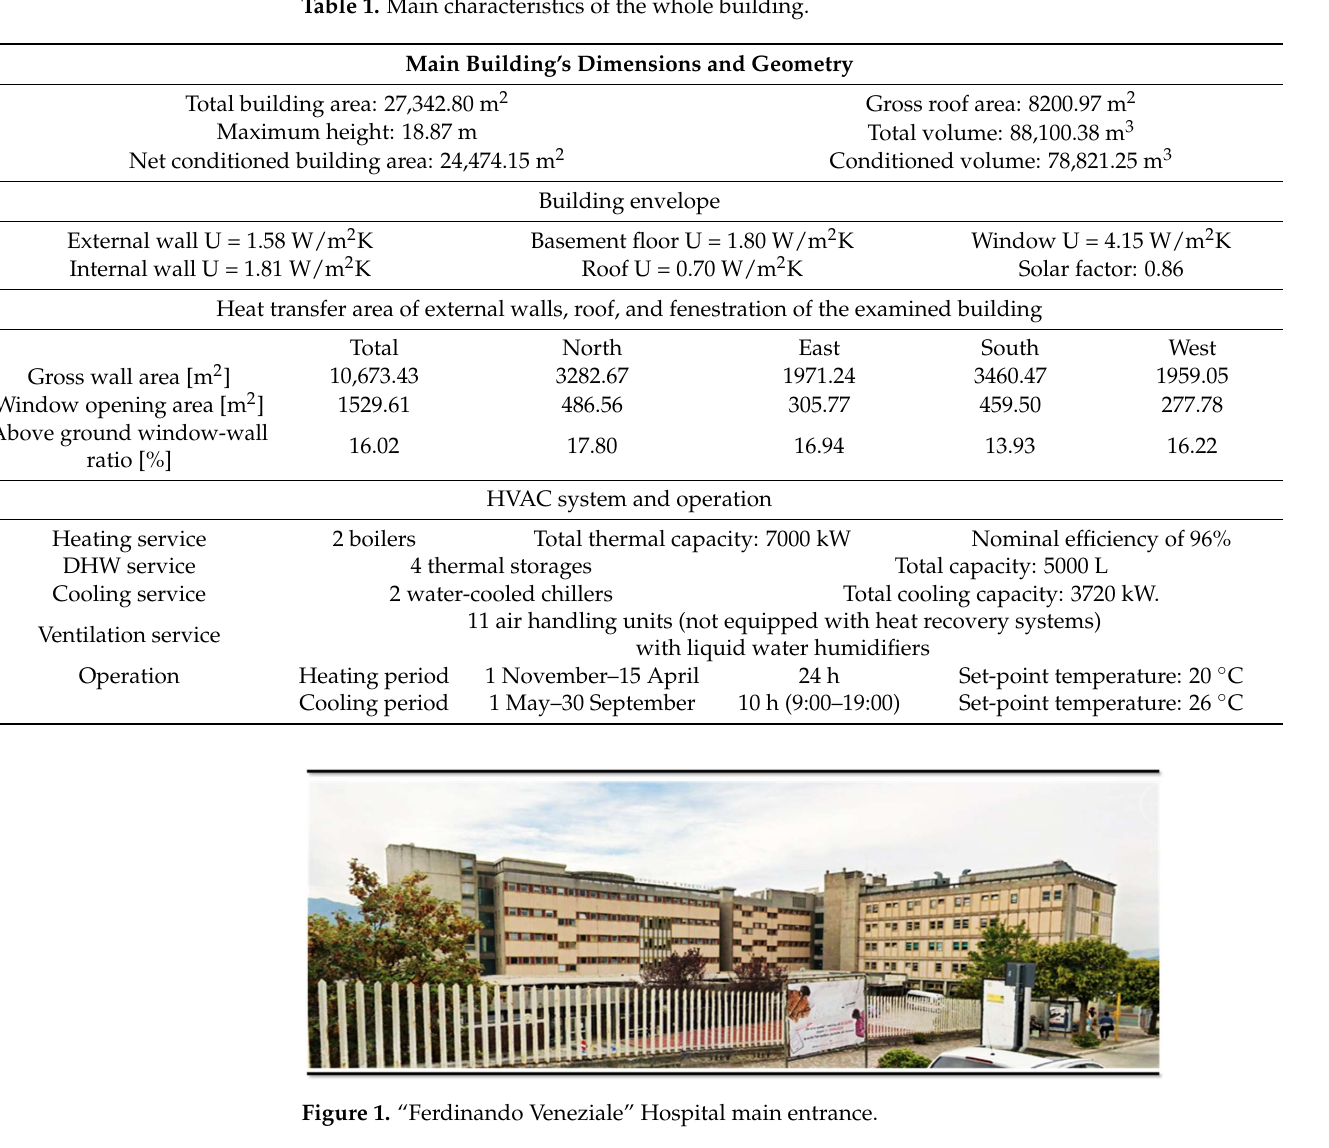
Table 1. Main characteristics of the whole building.